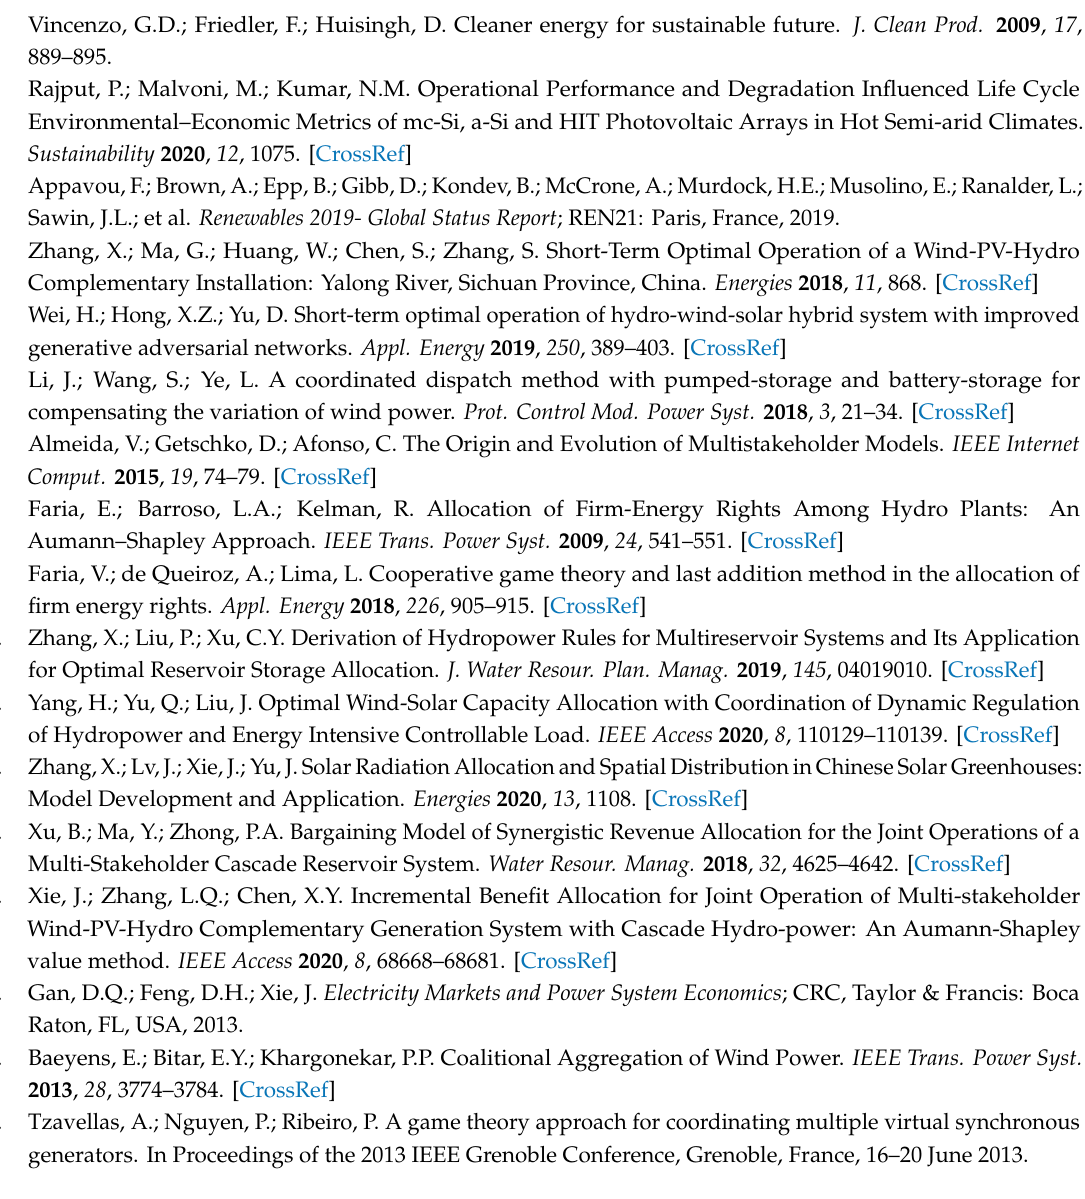
Figure A3. Natural inflow of a cascade of two hydro power stakeholders.